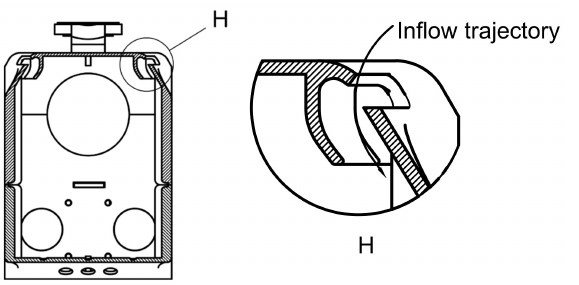
Figure 3. The frontal sectional view of the measurement chamber and zoomed-in view (H) of the downwash flow spoiler responsible for adjustments of flow velocity and direction.